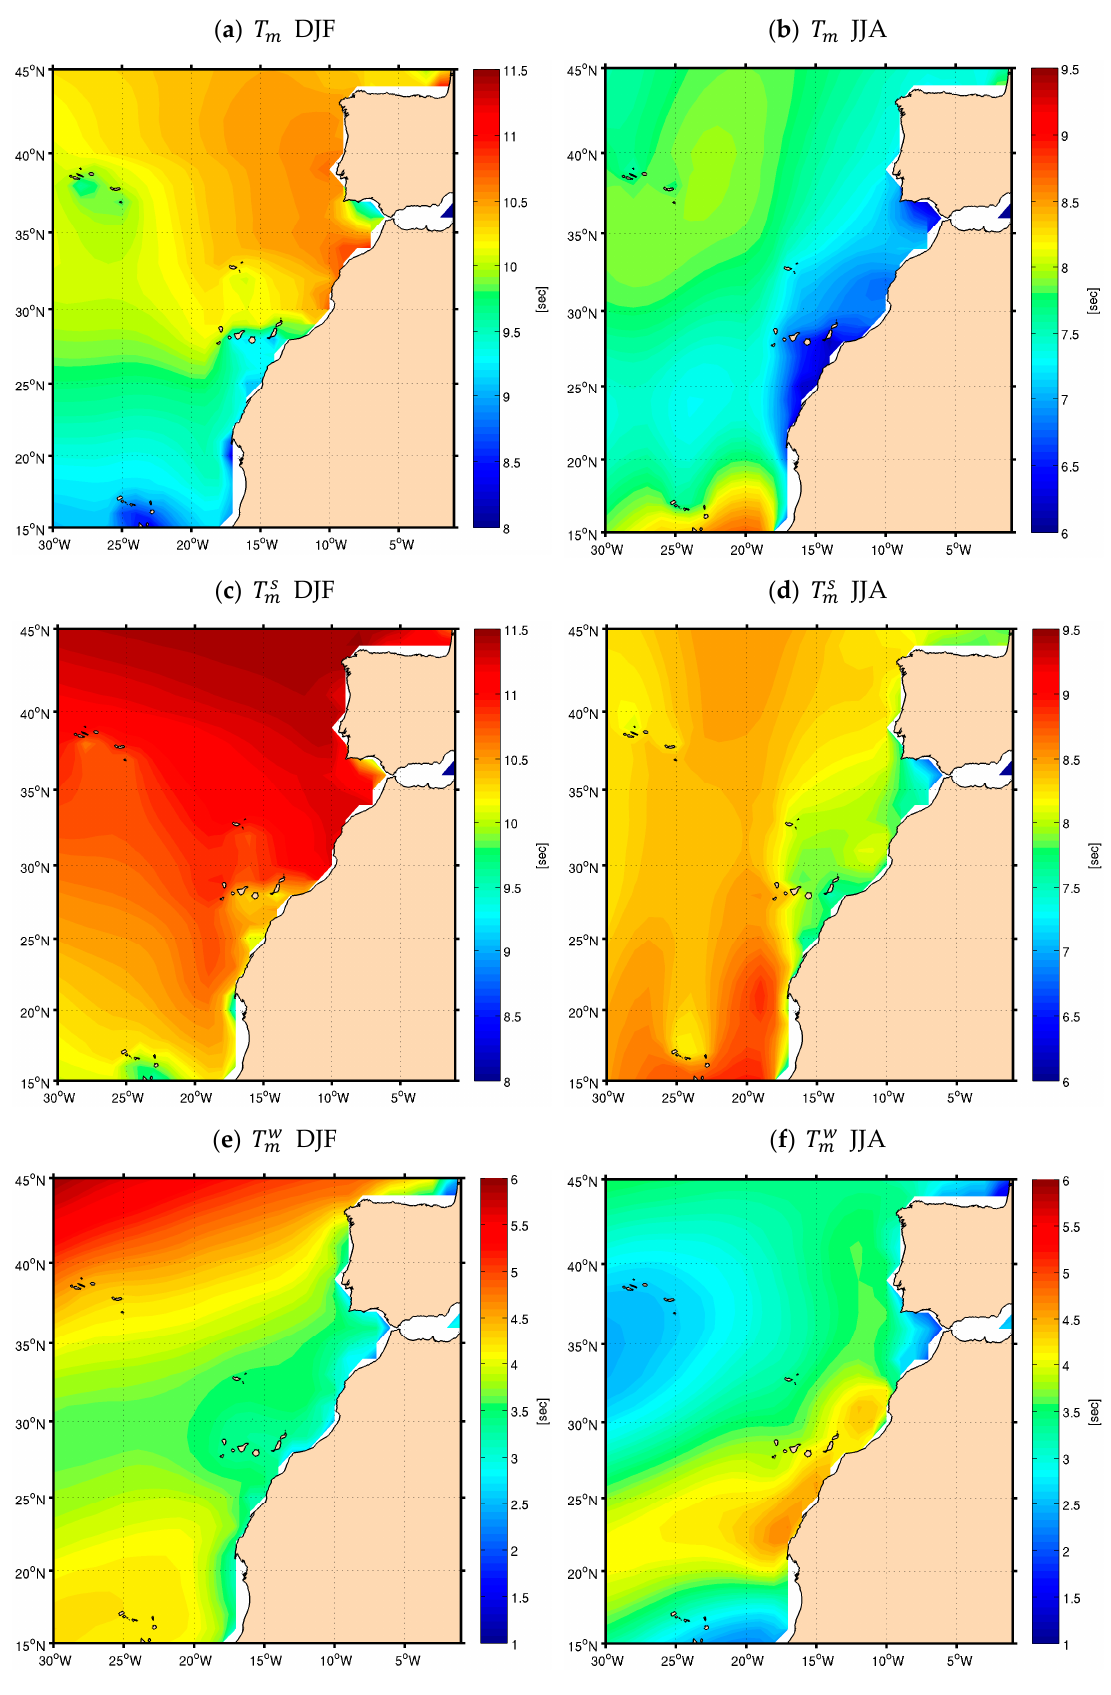
Figure 6. Climatological averages of T m (m) for ( a ) DJF and ( b ) JJA, of T s m (m) for ( c ) DJF and ( d ) JJA, and of T w m (m) for ( e ) DJF and ( f ) JJA. The color scales vary between